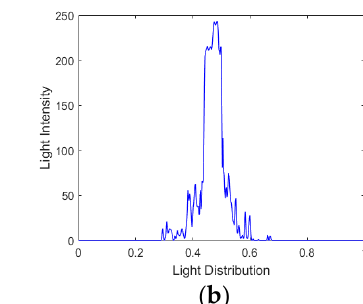
Figure 8. ( a ) The image captured by CCD after correction; ( b ) light intensity distribution.